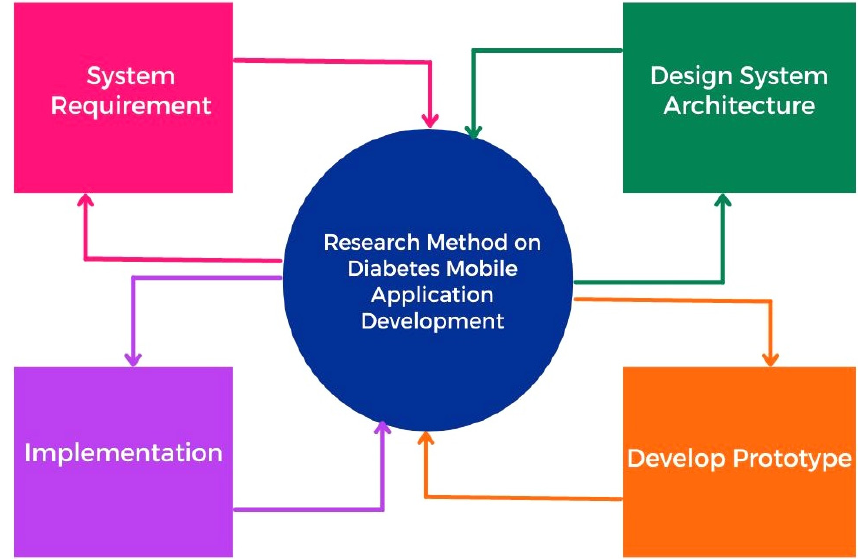
Figure 1. Research Method.